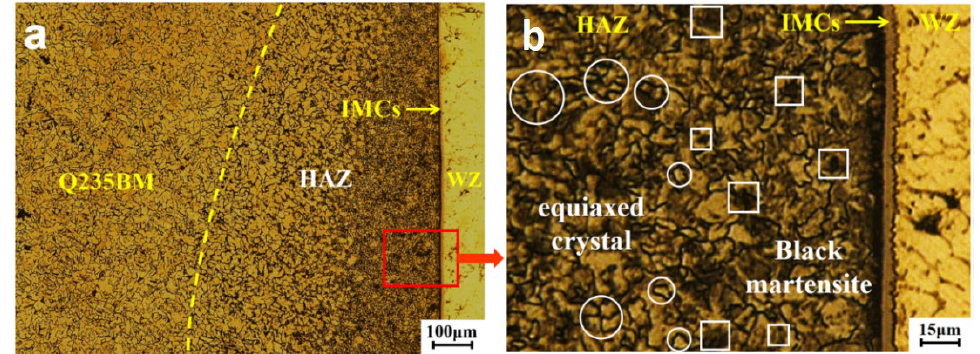
Figure 8. Microstructure of heat-affected zone near the steel: ( a ) microstructure under 100 μm; ( b ) microstructure under 15 μm.